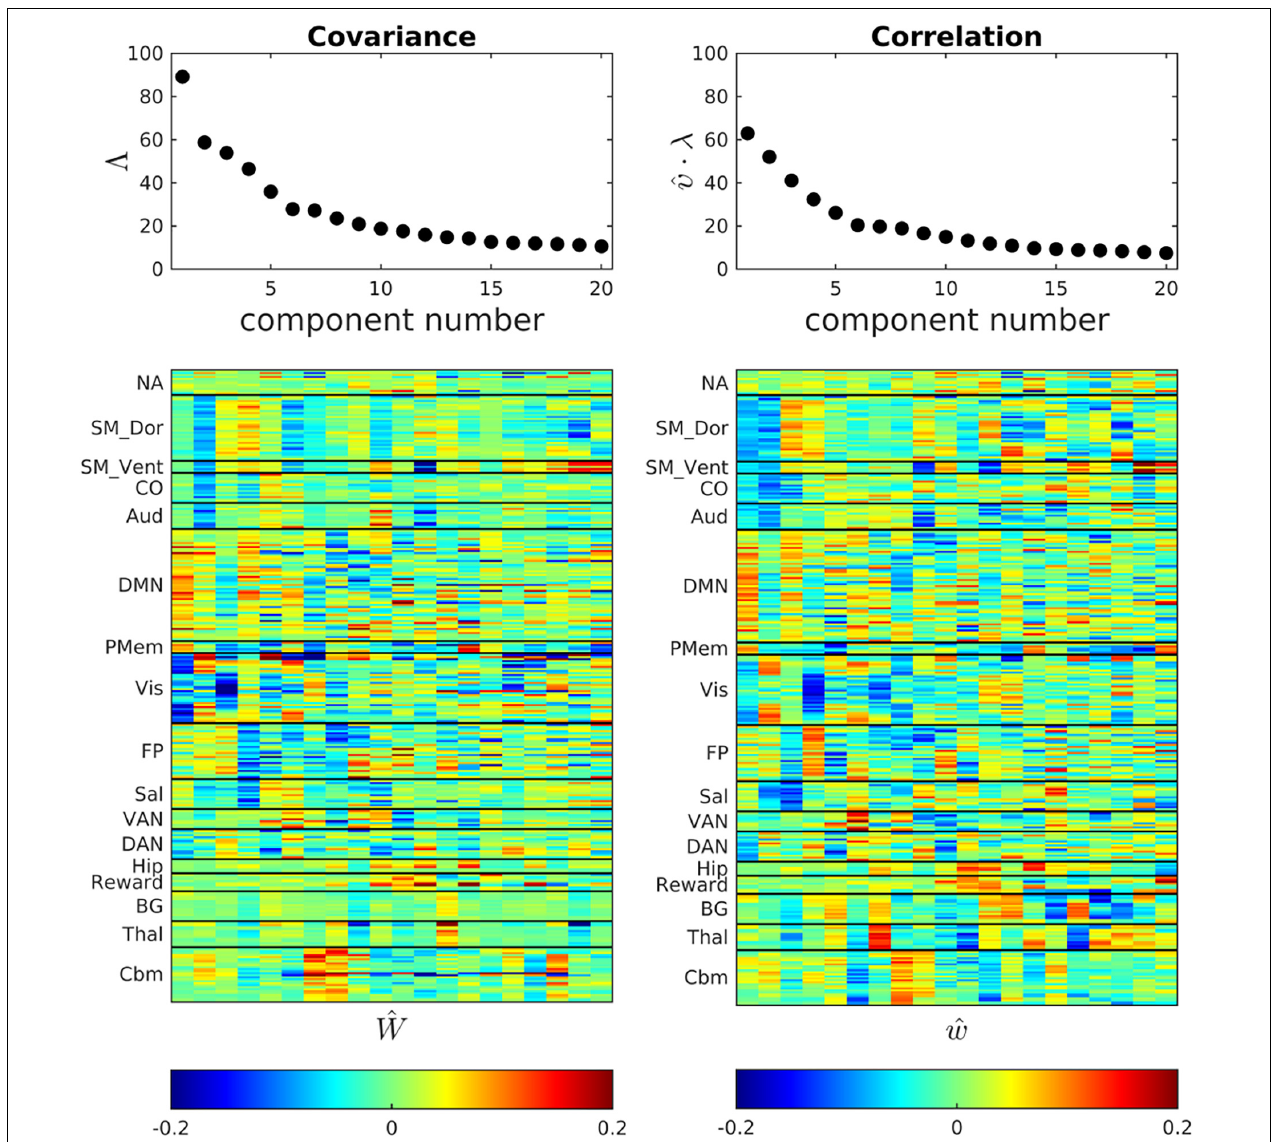
FIGURE 3 | ˆ C and ˆ r bases (eigenvectors) obtained by POD of the cohort-mean covariance and correlation FC matrices. Scree plots are shown above corresponding eigenvectors. The correlation eigenvectors have been multiplied by the scalar constant ( υ = 3.67) that minimizes error in the global, block-wise proportionality